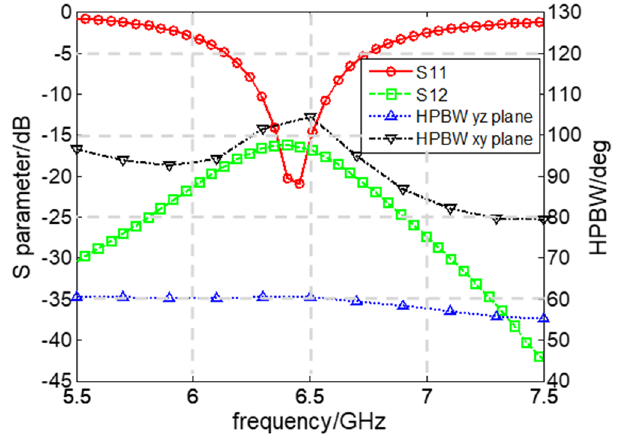
Figure 20. Structure of proposed anchor antennas. ( a ) Diagram of the patch array. ( b ) Photograph of the patch array and UWB chips.